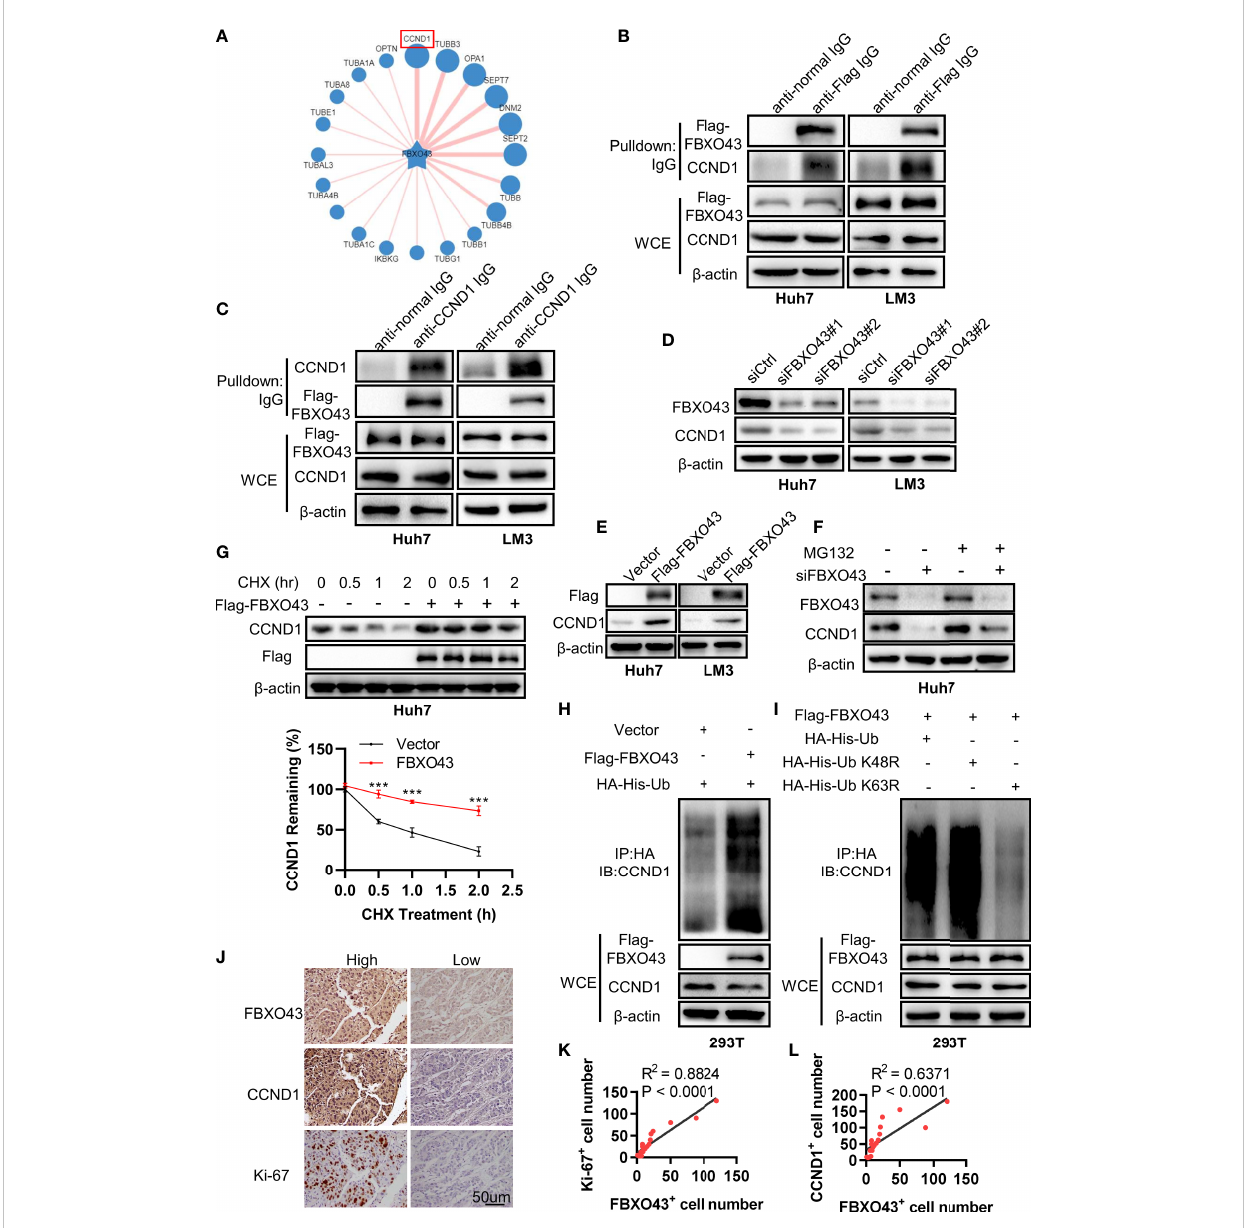
FIGURE 4 FBXO43 directly binds with CCND1 and promotes its stability. (A) Schematic diagram revealing the potential substrate of FBXO43 in the UbiBrower website. (B) Huh7 and LM3 cells were transfected with indicated plasmids for 48 hrs and then subjected to immunoprecipitation with anti-Flag or normal IgG antibody. The cell lysates were analyzed by Western blot. WCE, whole cell extract. (C) Huh7 and LM3 cells were transfected with indicated plasmids and then subjected to immunoprecipitation with anti-CCND1 or normal IgG antibody. The cell lysates were analyzed by Western blot. (D) The protein expression levels of FBXO43 and CCND1 were analyzed by Western blot in Huh7 and LM3 cells transfected with siCtrl or siFBXO43 for 48 hrs. (E) The protein expression levels of FBXO43 and CCND1 were measured by Western blot in Huh7 and LM3 cells transfected with indicated plasmids for 48 hrs. (F) Huh7 cells were transfected with siFBXO43 or siCtrl for 43 hrs and then treated with MG132 for 5 hrs before harvest for Western blot. (G) Huh7 cells were transfected with indicated plasmids for 48hrs and then treated with CHX (100 m g/mL) for 0, 0.5, 1, and 2 hrs before harvest for Western blot. The quanti fi cation plot was based on scanning densitometry analysis using the Image J software. Relative protein levels were normalized to Vector group. (H) CCND1 was polyubiquitylated by FBXO43. HEK293T were transfected with indicated plasmids for 48 hrs and then subjected to immunoprecipitation with anti-HA antibody. The cell lysates were analyzed by Western blot. (I) FBXO43 mediated K63-linked polyubiquitination of CCND1. HEK293T cells were transfected with the FBXO43 plasmids along with WT-ubiquitin or its mutants (K63R and K48R) for 48 hrs and then subjected to immunoprecipitation with anti-HA antibody. The cell lysates were analyzed by Western blot. (J) Immunohistochemical staining was performed in HCC patients using anti-FBXO43, anti-CCND1, and anti-Ki-67 antibodies (n=20). FBXO43-positive, CCND1-positive, or Ki-67-positive cells were counted in 500 cells for each group. (K, L) Linear regressions were used to analyze the association between FBXO43- and CCND1-positive cells (K) , and FBXO43- and Ki-67-positive cells (L) . Two-tailed t-test was used.